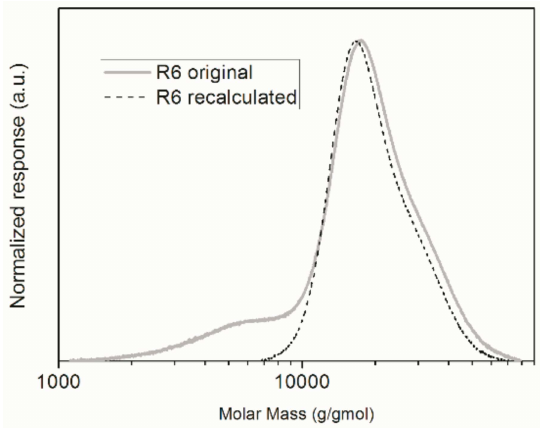
Figure 5. GPC chromatograms of the final polymer product of R6.